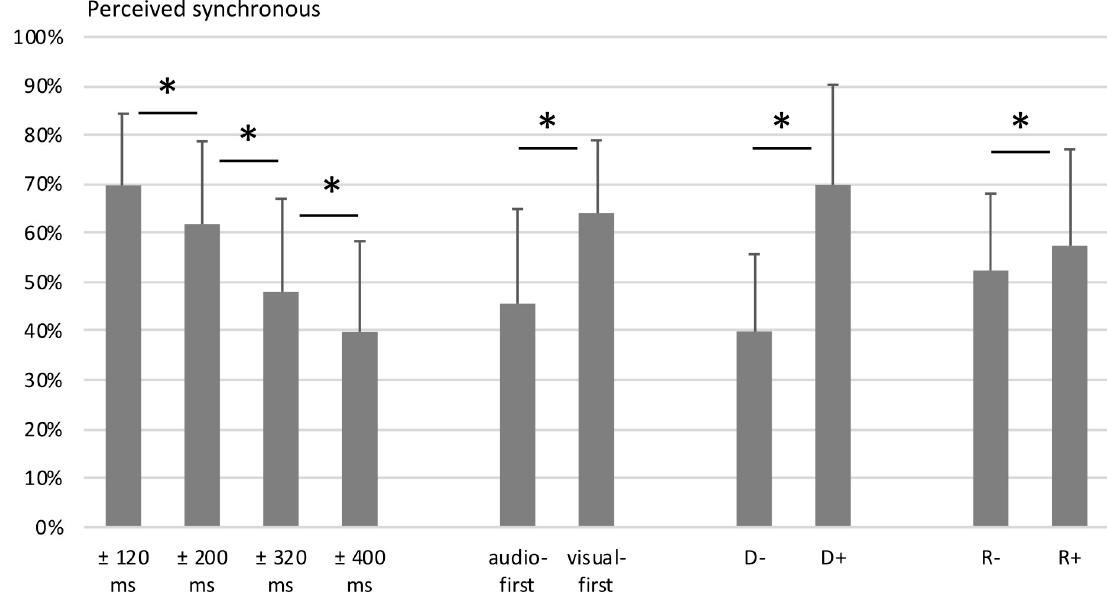
Fig 5. Main effects of the audiovisual (a)synchrony ratings, Study 2. Mean percentages of trials perceived as synchronous, aggregated for the factors asynchrony size, asynchrony type, Event density (D- standing for low, D+ for high density) and Rhythmicity (R- and R+ for low and high rhythmicity, respectively). Error bars represent the standard deviation. Significant differences are marked with asterisks.